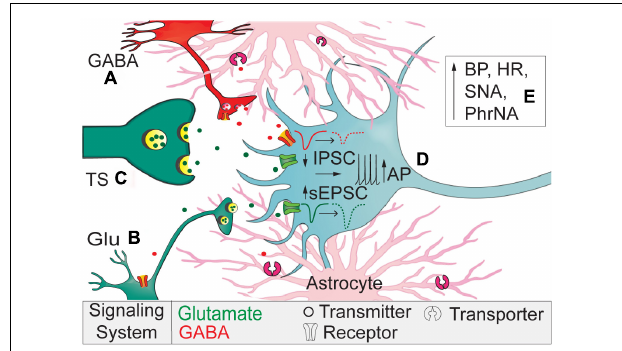
FIGURE 7 | Working model. Astrocytic GAT-3 modulates extracellular GABA and GABA and Glu signaling. (A) Block of GAT-3 reduces interneuron somal activity or its release of GABA via autoreceptor activation. (B) Reduced GABA release disinhibits sEPSCs originating from higher-order neurons to elevate current frequency and amplitude. (C) The lack of effect of SNAP 5114 on TS-EPSCs suggest minimal expression of GAT-3 near primary afferents compared to higher-order neurons and synapses. (D) The reduced IPSCs and augmented sEPSCs depolarizes nTS second-order somas to increase discharge. (E) Overall, GAT-3 inhibition enhances BP, HR, sympathetic, and phrenic nerve